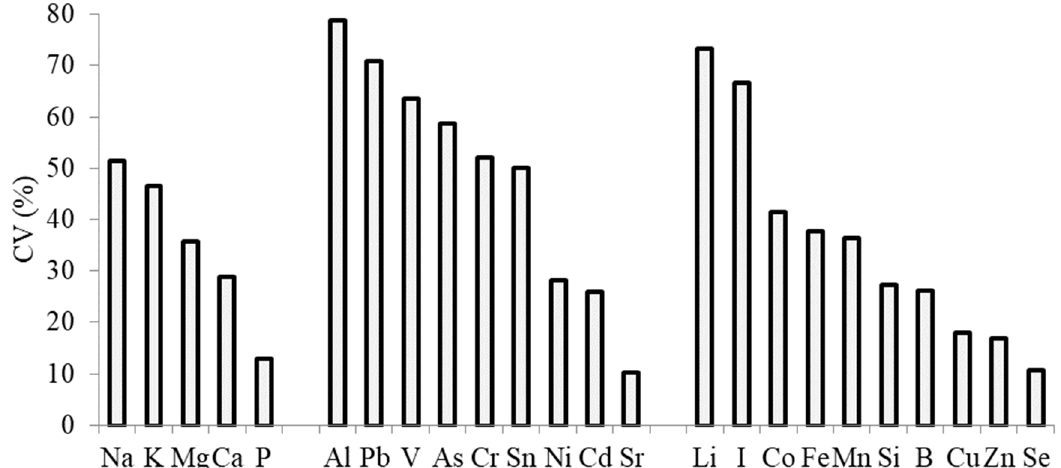
Figure 7. Coefficients of variation relevant to macro- and microelement content in A.porrum .